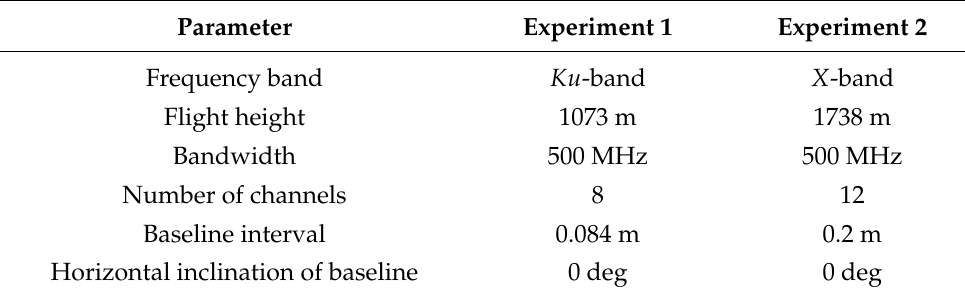
Table 3. Main system